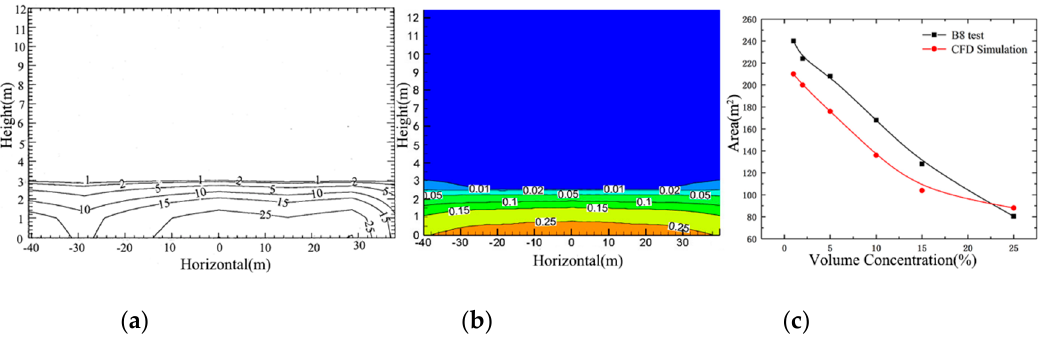
Figure 3. Comparison of experimental and simulated values of methane volume concentration at a vertical height of 1 m.